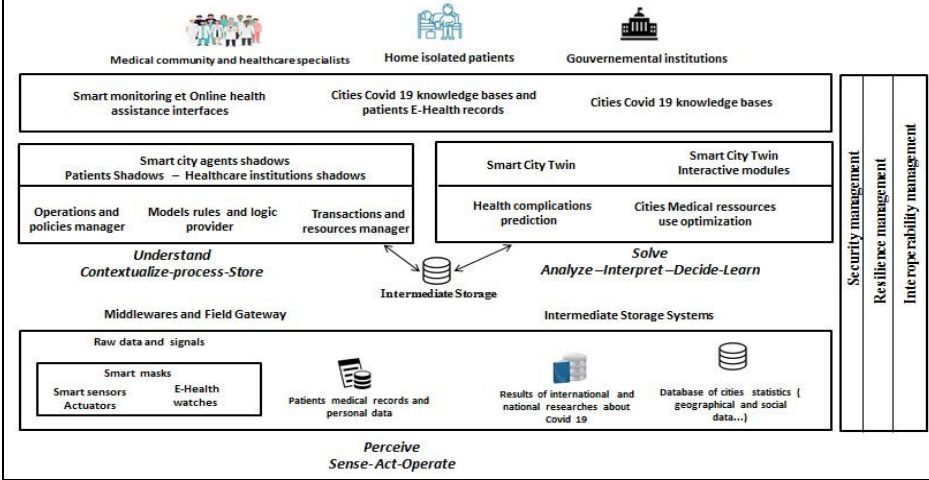
Figure 3. In-house Oxy